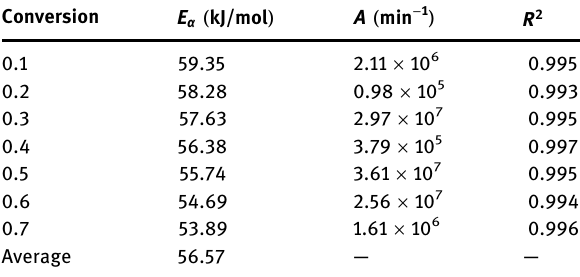
Table 8: Combustion kinetic parameters of sample K5